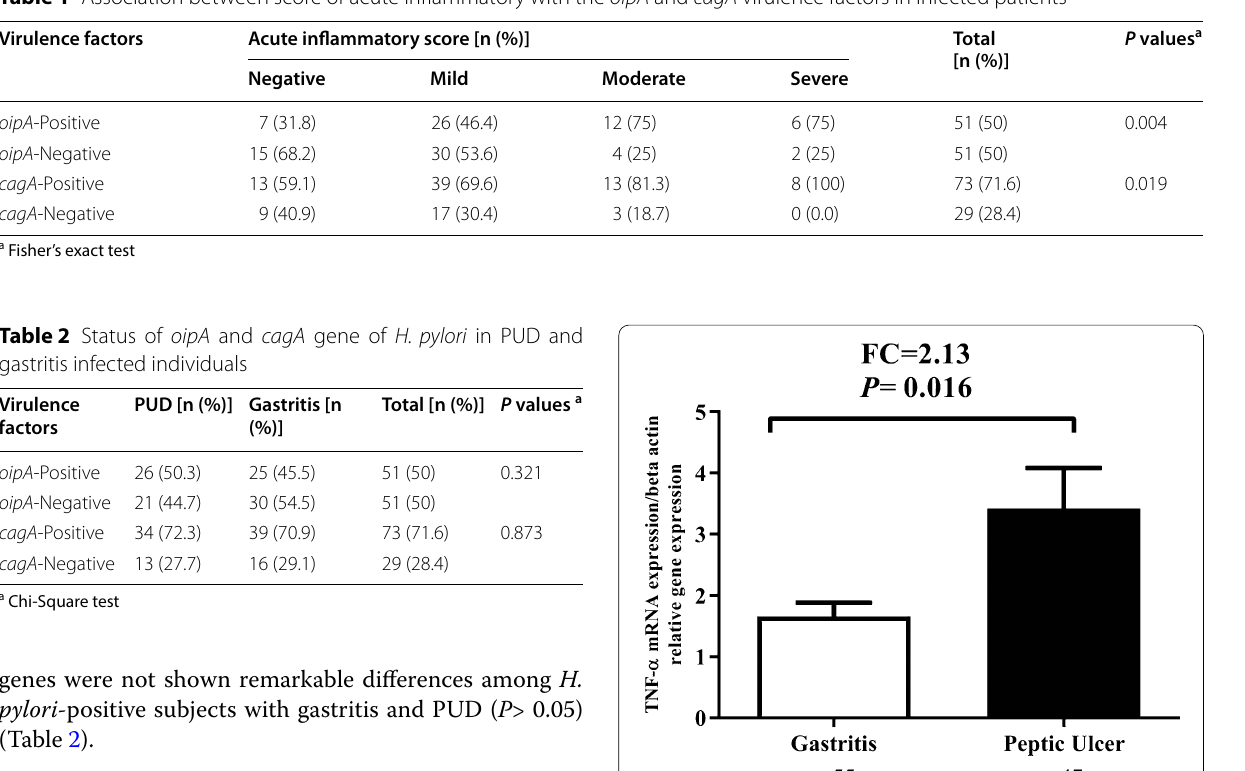
Comparison of TNF‑α mRNA expression at H. pylori ‑positive